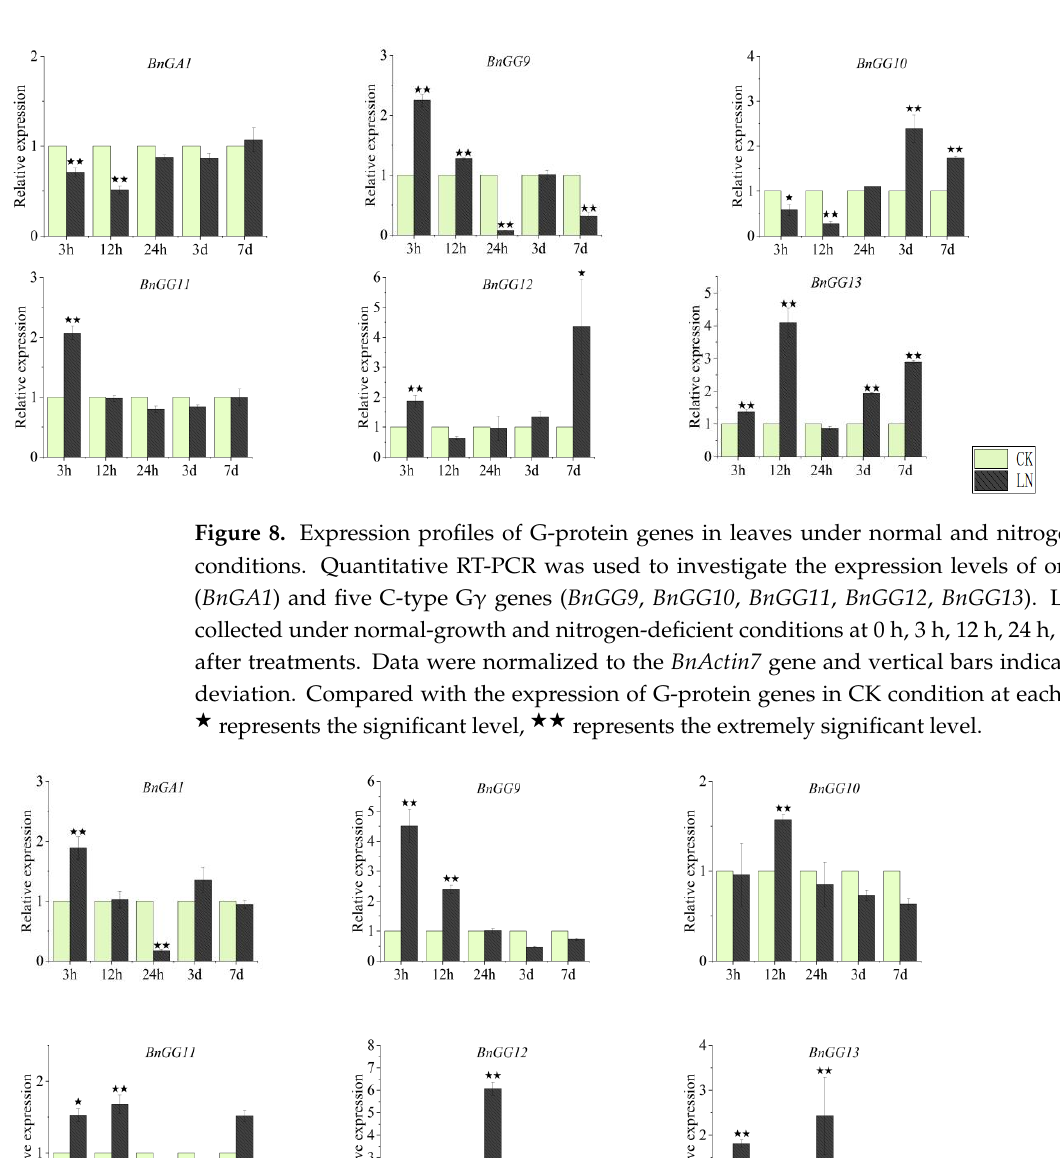
11 of 18 Figure 7. Expression profiles of G-proteins in different tissues and organs of B. napus . FPKM values of G-protein genes were transformed by log2 and the heatmap was constructed by TBtools. 2.7. Expression Patterns of G-Protein Genes under Nitrogen Deficiency To investigate the expression patterns of B. napus G-protein genes under nitrogen deficiency, seedling leaves and seedling roots were harvested at various time points (0 to 7 d) after culturing in a Hoagland nutrient solution with high nitrogen (normal N condi- tion, CK) and low nitrogen (N deficient condition, LN) content. In leaves (Figure 8), under LN treatment, G α subunit gene BnGA1 was significantly downregulated immediately and